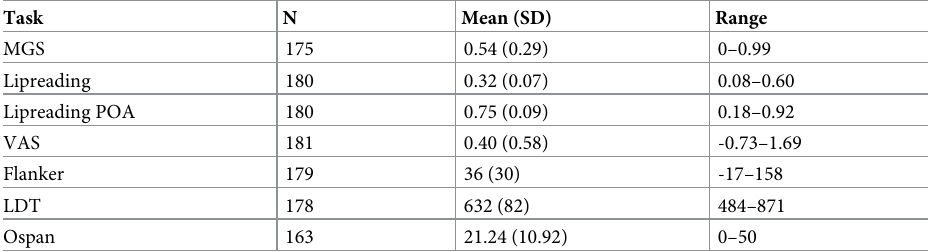
Table 2. Summary statistics for all